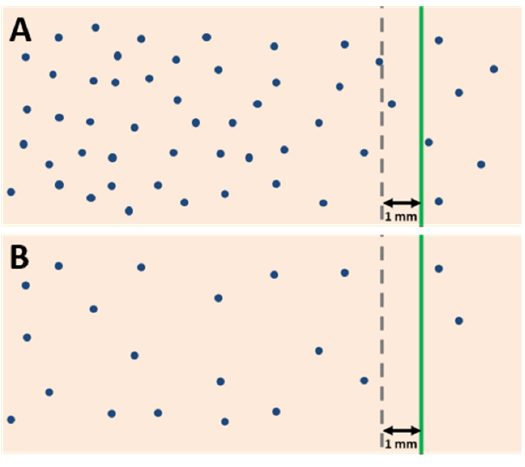
Figure 4. Margin clearance in treatment-naïve PDAC ( A ) and in PDAC following neoadjuvant therapy ( B ). A treatment-naïve tumour with clearance ≤ 1 mm is considered R1. However, following neoadjuvant therapy, a clearance of >1 mm does not preclude the presence of residual cancer in the surgical bed (R1) because, due to partial tumour regression, the distance between residual cancer cells may become considerably larger ( blue dots: cancer cells, green line: resection margin, grey interrupted line: 1 mm clearance).